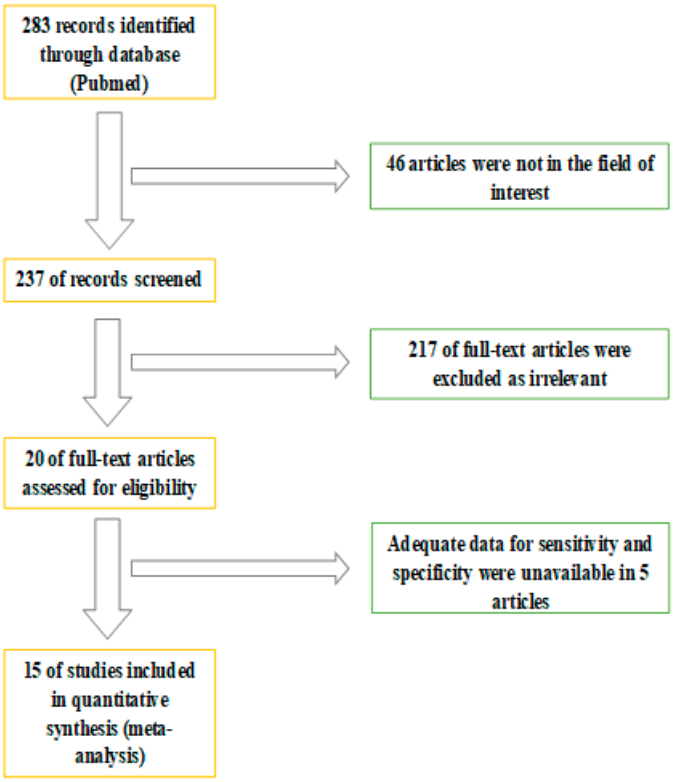
Figure 1. Flowchart of information through the different phases of the systematic review. The diagnostic performance results of 18F-Fluciclovine PET/CT for the diagnosis of primary cancer, pre-operative LN staging, for prostate disease recovery, and for bone metas- tasis assessment are shown in Table 2. Pooled sensitivity and specificity were calculated according to a patient-based analysis. Table 2. Authors, patients, and study